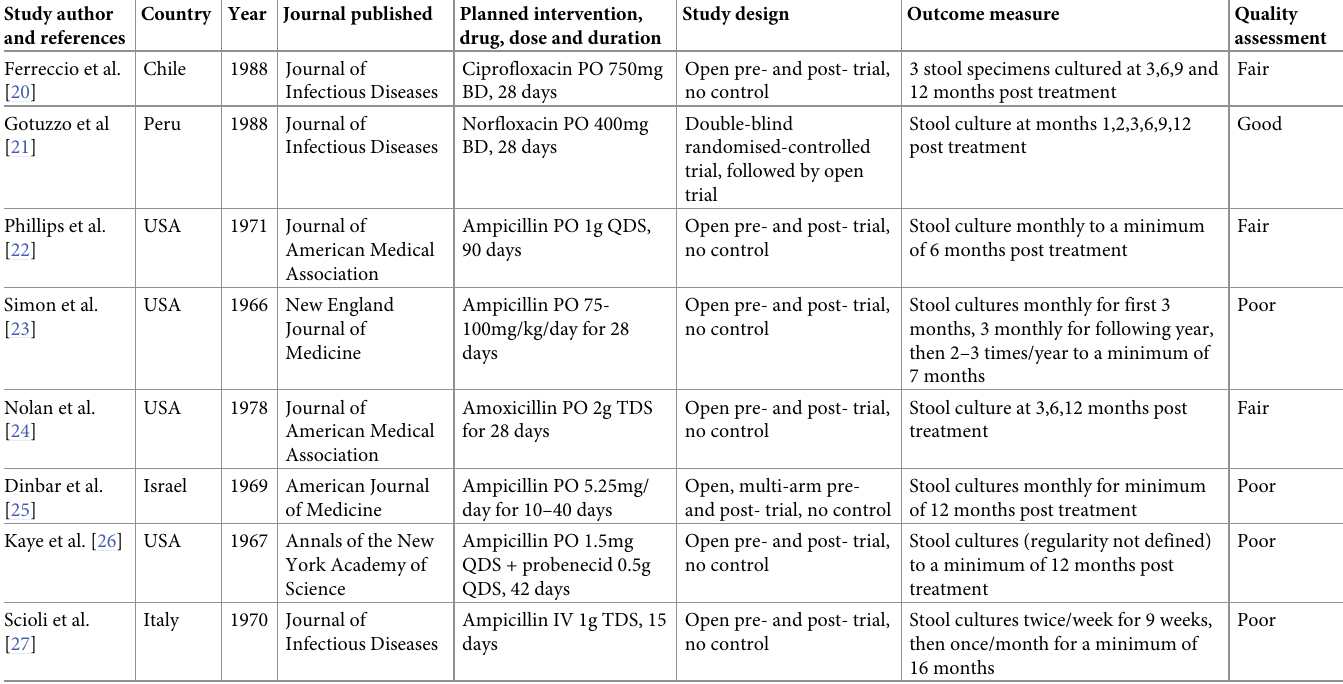
Table 1. Summary of included